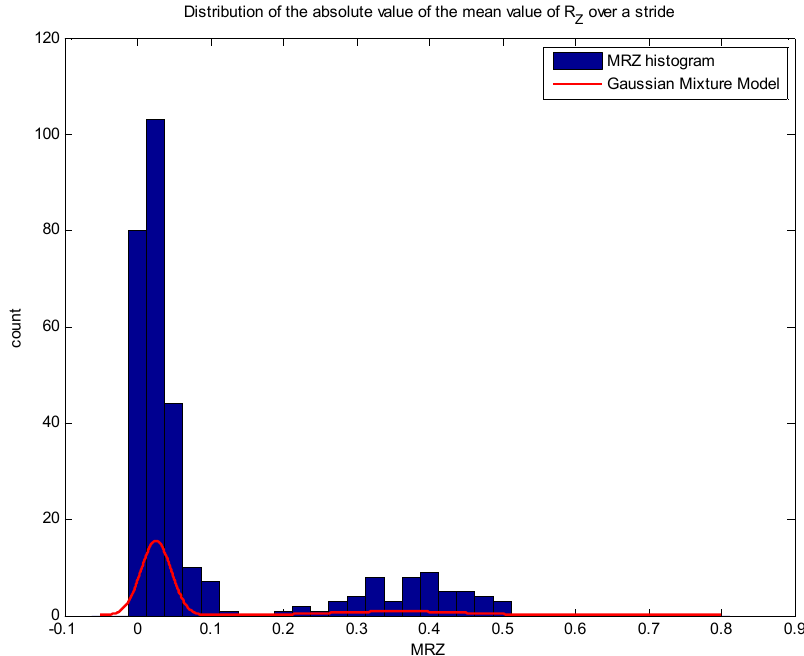
Figure 2. Distribution of the absolute value of the mean of R to zero corresponds to straight walking, while the peak to the left corresponds to turning steps. The red line shows the fitted Gaussian mixture model.